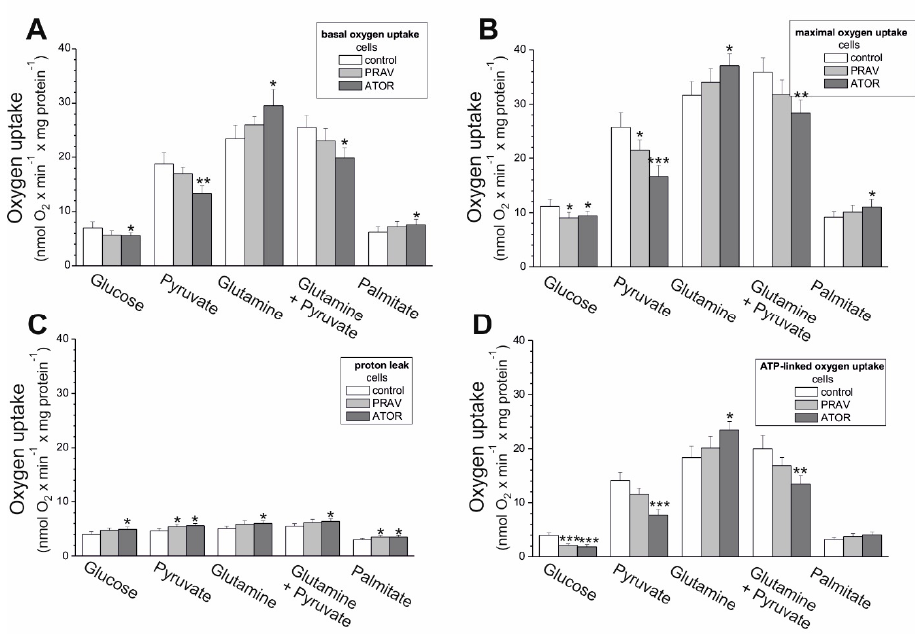
Figure 3. Oxidative metabolism of EA.hy926 cells grown with 100 nM PRAV or 100 nM ATOR. Substrate ‐ dependent changes in the basal oxygen consumption rate (OCR) ( A ), maximal OCR ( B ), proton leak ( C ), and ATP ‐ dependent OCR ( D ). Mean ± SD; n = 6; p < 0.05 (*), p < 0.01 (**), and p < 0.001 (***), comparison vs. control values.